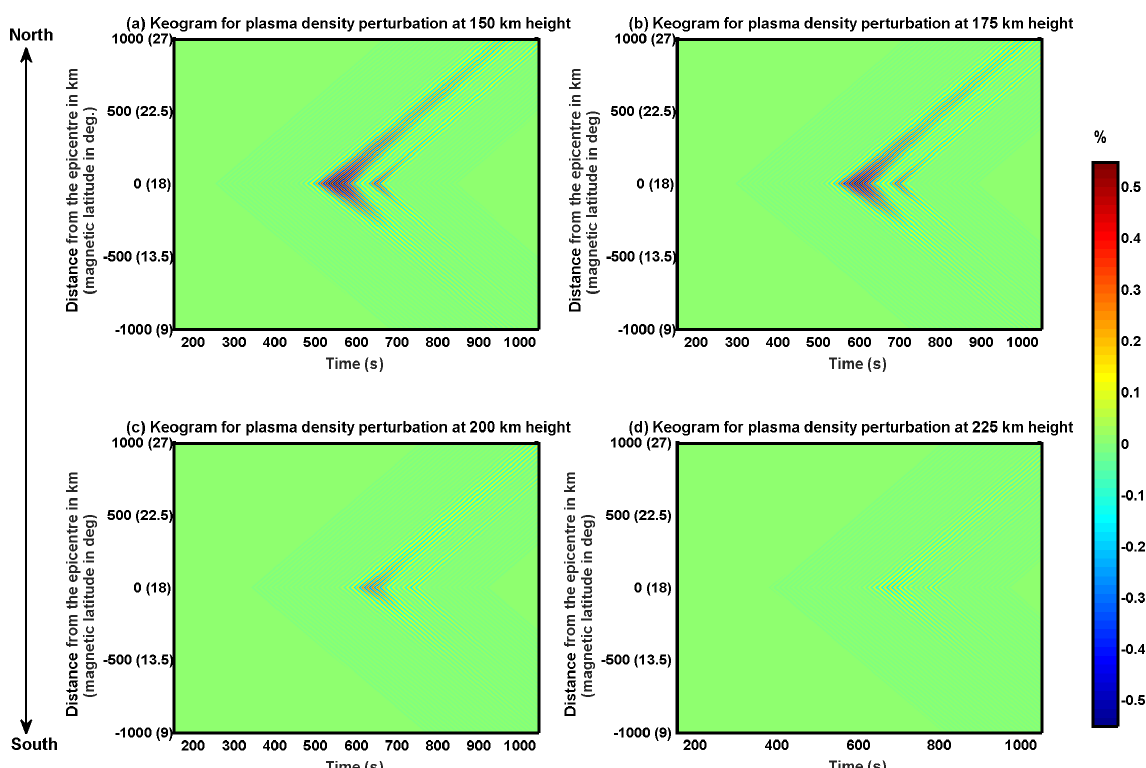
Figure 8. Ionospheric response to the seismic infrasound in the SAMI2 model. (a–d) Displacement–time diagrams (keogram) of ionospheric perturbations at 150, 175, 200 and 225km heights, respectively. Even though the infrasound propagation (as shown in Fig. 3b) is symmetric in north–south directions, the ionospheric response to it in SAMI2 model is